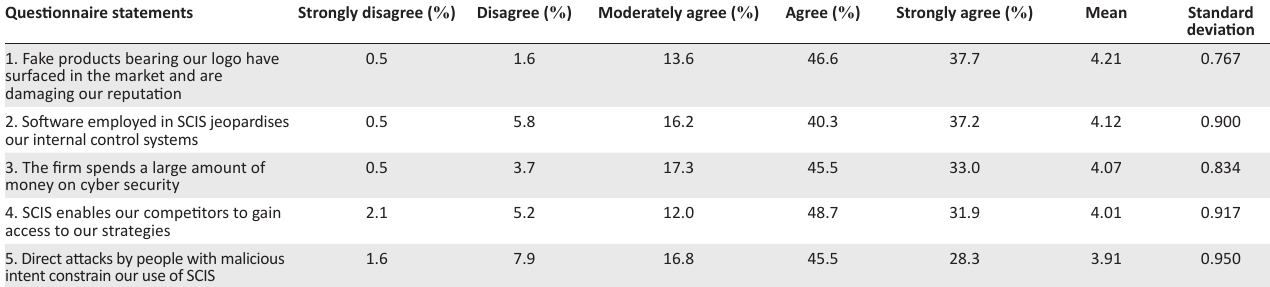
TABLE 4 : Consequences of supply chain information systems in the textile supply